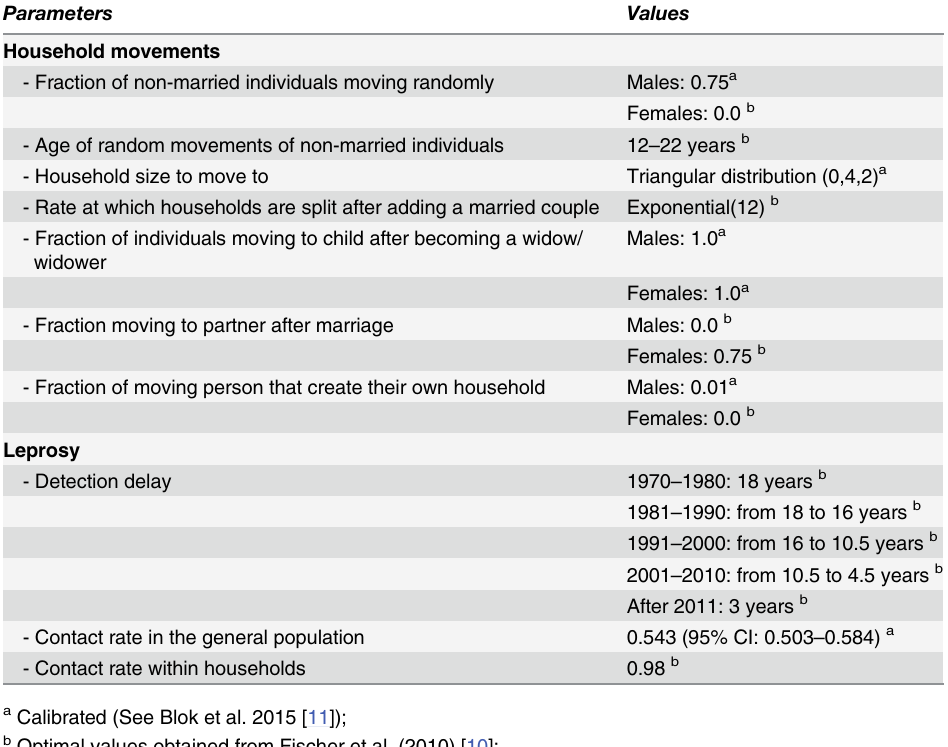
Table 1. Overview of calibrated